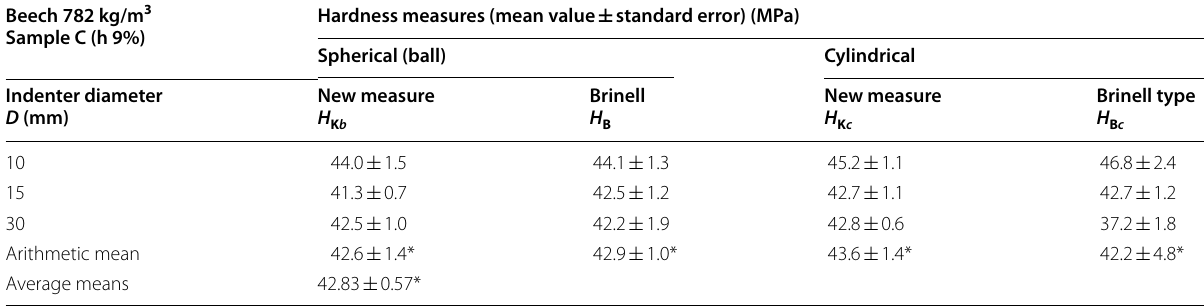
*Standard deviation of the type s m